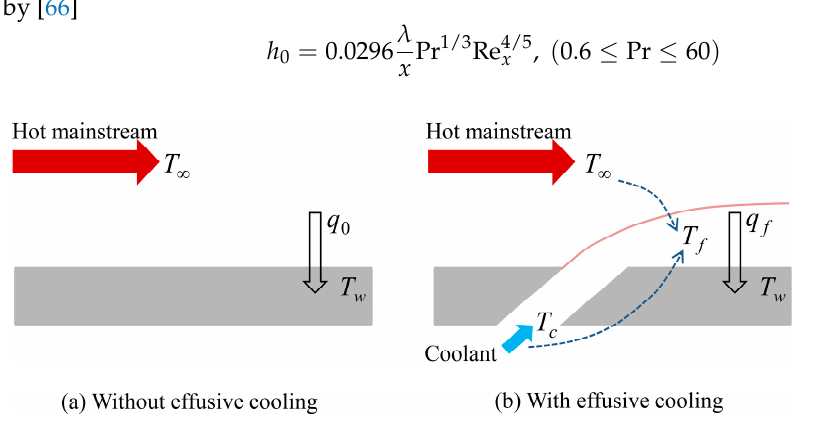
Figure 5. Schematics of heat transfer without or with effusive cooling.